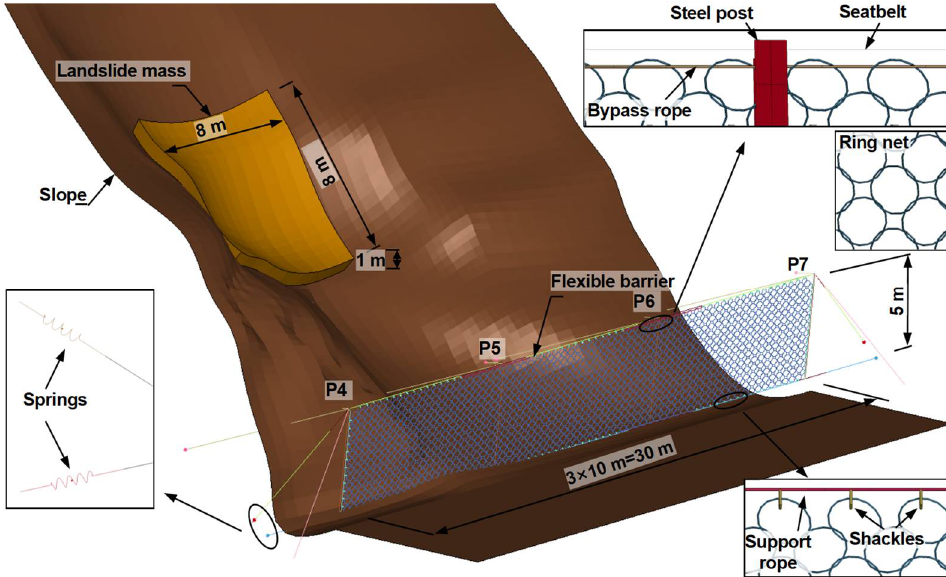
Figure 7. An isometric view of the back analyzed model.